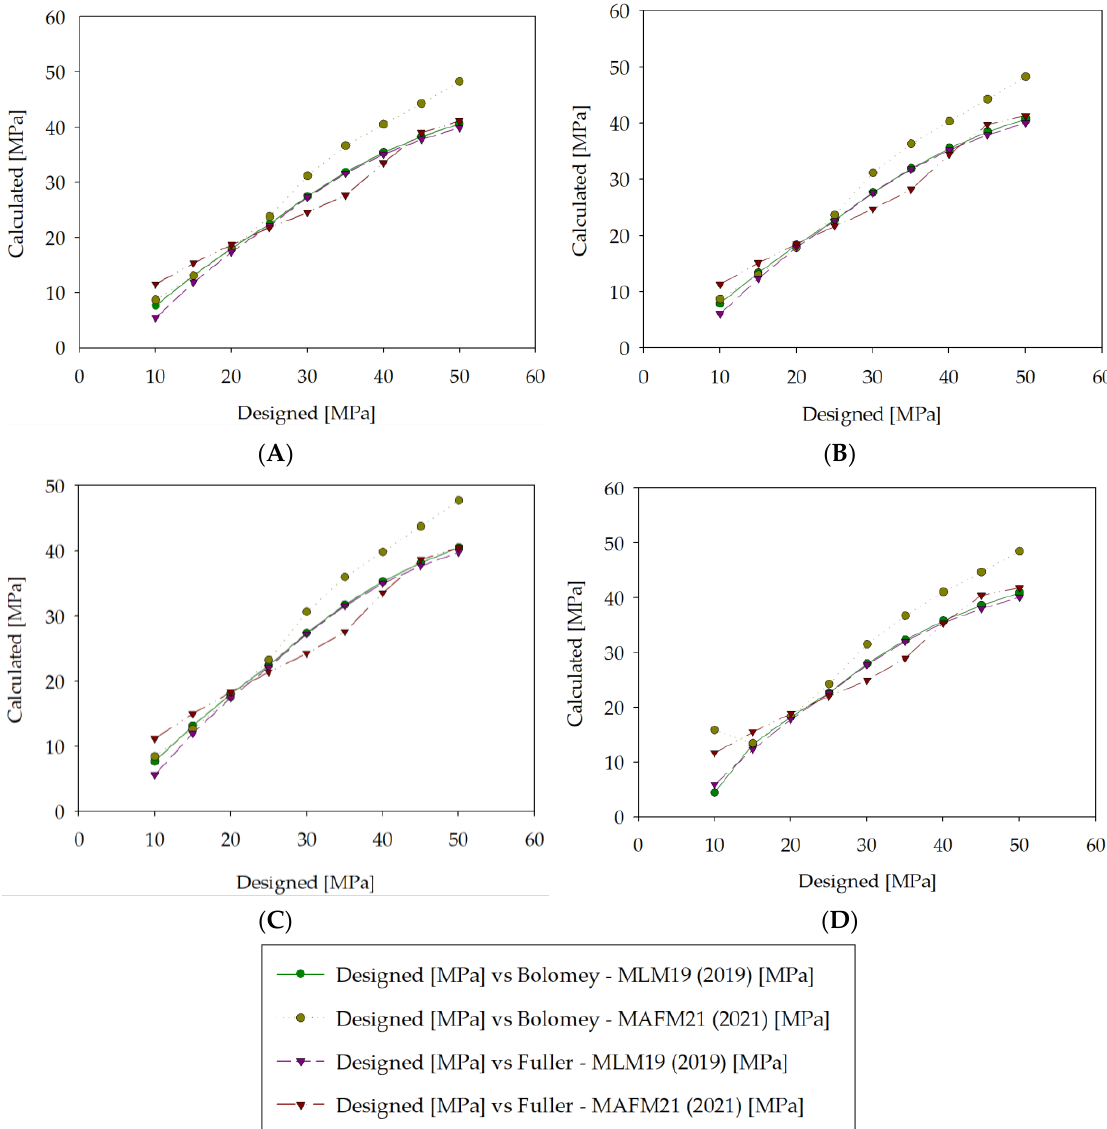
Figure 6. Comparison between designed concrete compressive strength and calculated concrete compressive strength according to MLM19 (Machine Learning Model 2019) and MAFM21 formulas for four recipes calculated according to the Bolomey and Fuller methods. ( A ) Recipe #1—standard mix + plasticizer (lignosulfonate) + superplasticizer (polycarboxylate ether); ( B ) Recipe #2—standard mix + plasticizer (lignosulfonate) + superplasticizer (polycarboxylate ether) + air entrainer (tensides); ( C ) Recipe #3—standard mix + superplasticizer (polycarboxylate ether) + retarder (phosphate) + air entrainer (tensides); ( D ) Recipe #4—standard mix + plasticizer (lignosulfonate) + superplasticizer (naphthalene). The comparative analysis of errors is presented in Figure 7.